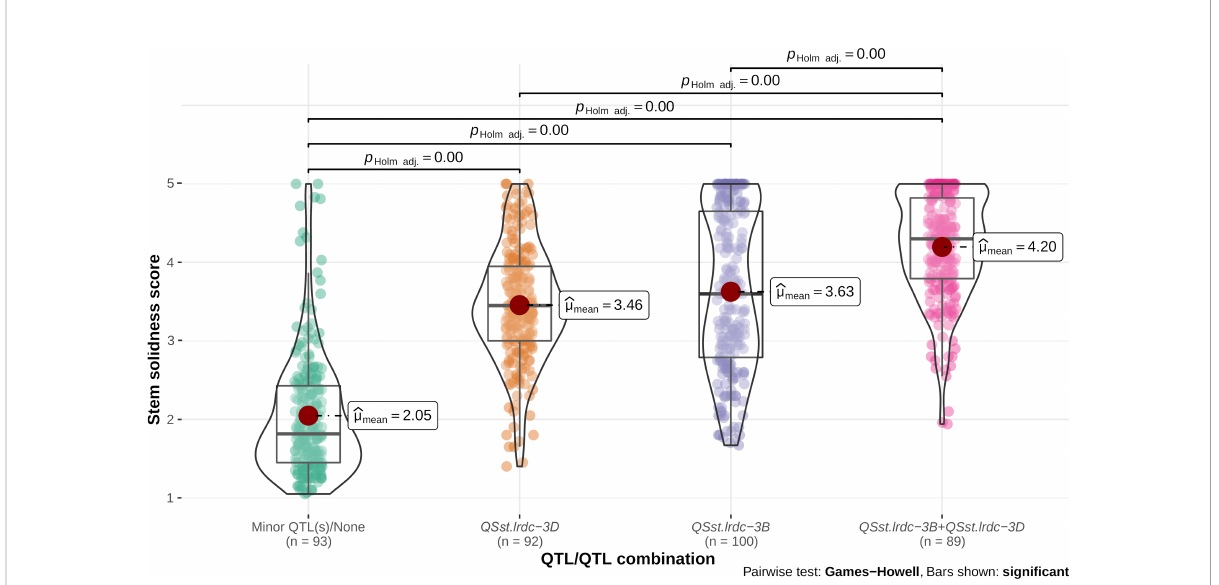
FIGURE 10 Violin plot and box plot distribution of stem solidness score in doubled haploid lines carrying (i) minor QTL(s)/none, (ii) major QTL QSst.lrdc-3D , (iii) major QTL QSst.lrdc-3B , and (iv) major QTL combination QSst.lrdc-3B and QSst.lrdc-3D in ‘ AAC Innova/P2711 ’ population. The violin plots (transparent) and different color- fi lled circles represent the data distribution. Quartiles and medians are represented by boxes and continuous lines (gray color), respectively. The mean is shown by dark red color dots. Whiskers extend to the farthest points that are not outliers. Signi fi cant differences are shown by bar and p